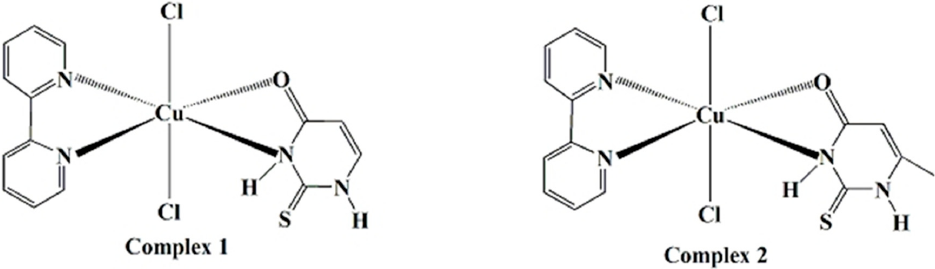
Figure 1. Proposed structures for the complexes 1 and 2.